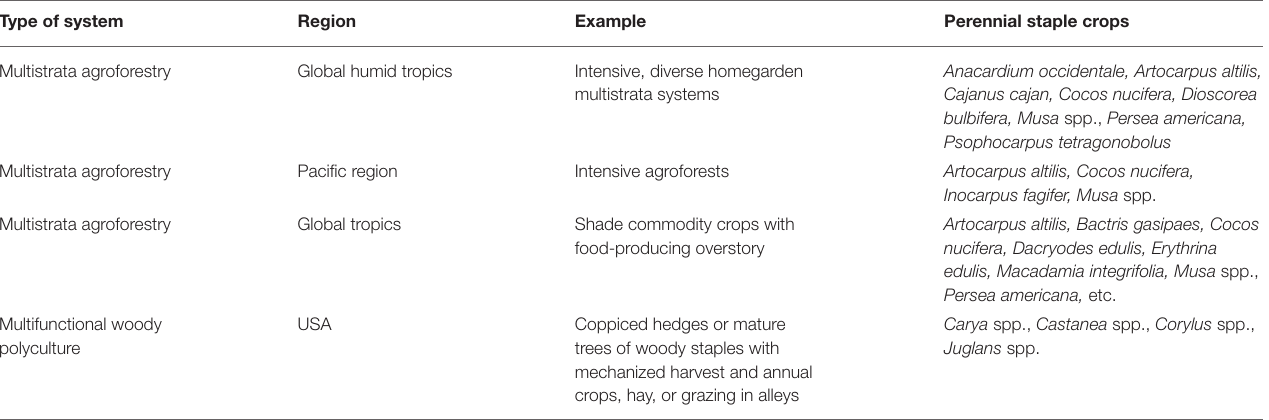
TABLE 5 | Samples of fully perennial agroforestry systems featuring perennial staple